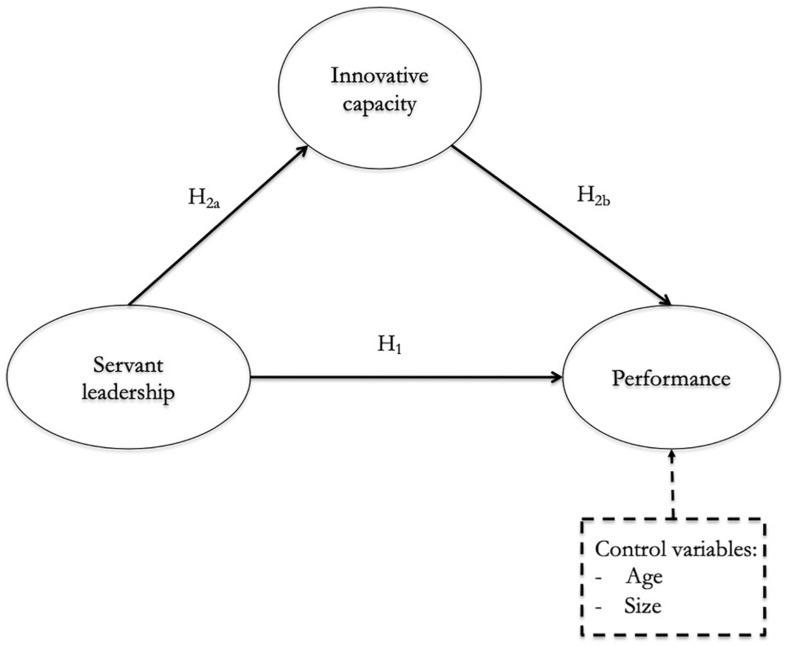
Investigation model.